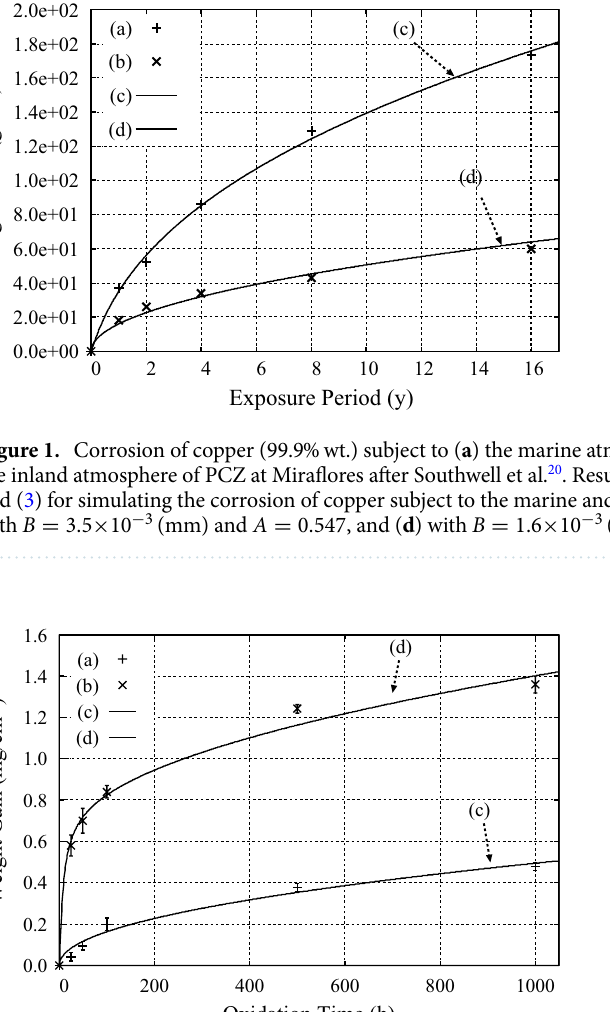
Figure 2. Experimental results on the weight gain of the oxidation of 316LSS ( a ) at T 800 ◦ C after Huang et al. 22 . ( c ), ( d ) Results of the calculations by using Eqs. (1) and (3) with the use of ( c ) T = 1.50 10 − 2 (mg/cm 2 ) and A B = × 800 ◦ C, T =